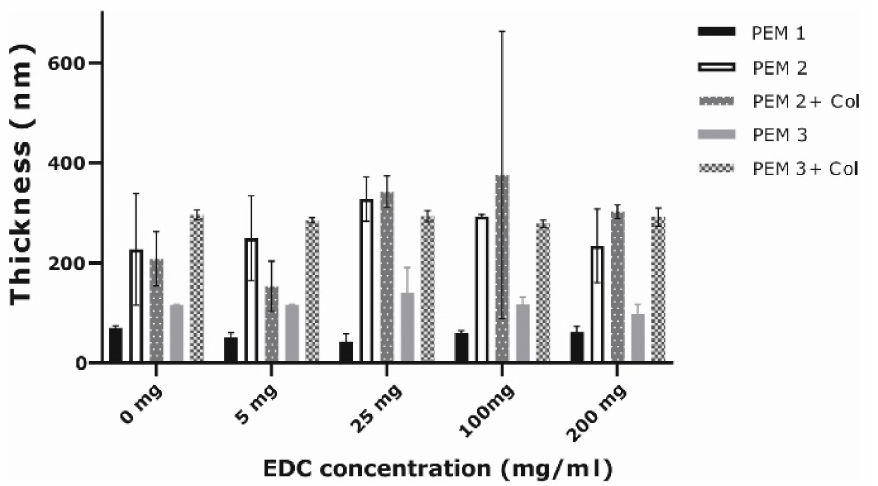
Figure 5. Film thickness from cross-linked film systems measured with ellipsometry. Data were obtained from three independent samples and three random areas for each sample. Film thickness was calculated with a Cauchy model.